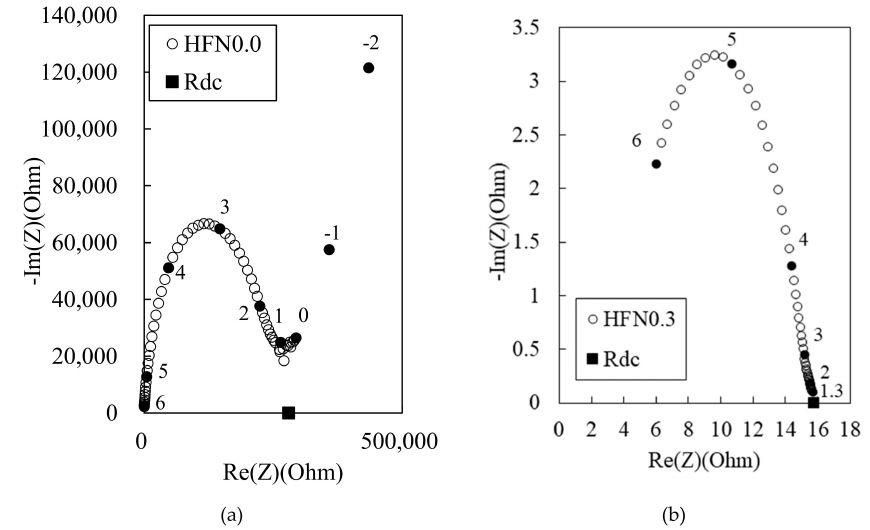
Figure 7. Experimental Nyquist plot for 180 MPa-HPFRCC with ( a ) 0% and ( b ) 0.3% (w / c ratio of 0.25).